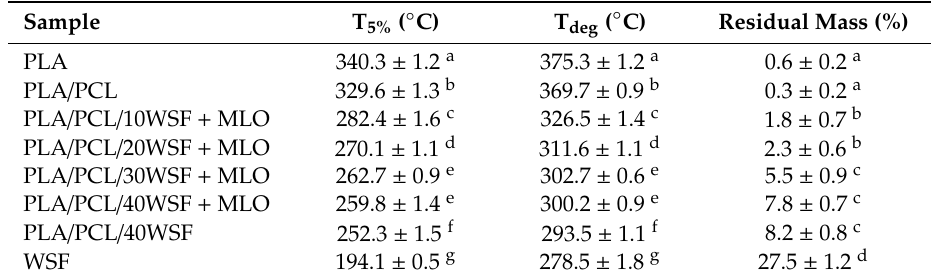
Table 4. Main thermal parameters of the green composites made of polylactide (PLA), poly( ε -caprolactone) (PCL), walnut shell flour (WSF), and maleinized linseed oil (MLO) in terms of: onset temperature of degradation (T 5% ), degradation temperature (T deg ), and residual mass at 700 ◦